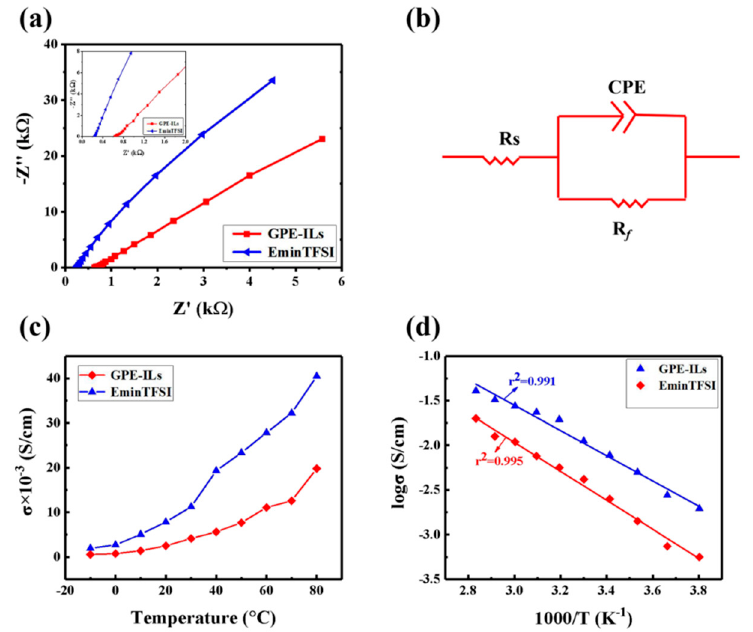
Figure 4. ( a ) Nyquist plots of different electrolytes at 25 ◦ C. ( b ) The equivalent circuit for electrolytes in present work. ( c ) Ionic conductivity of GPE-ILs and the ionic liquid in the range from − 10 to 80 ◦ C. ( d ) Temperature dependence of the ionic conductivity of the GPE-ILs and the ionic liquid.